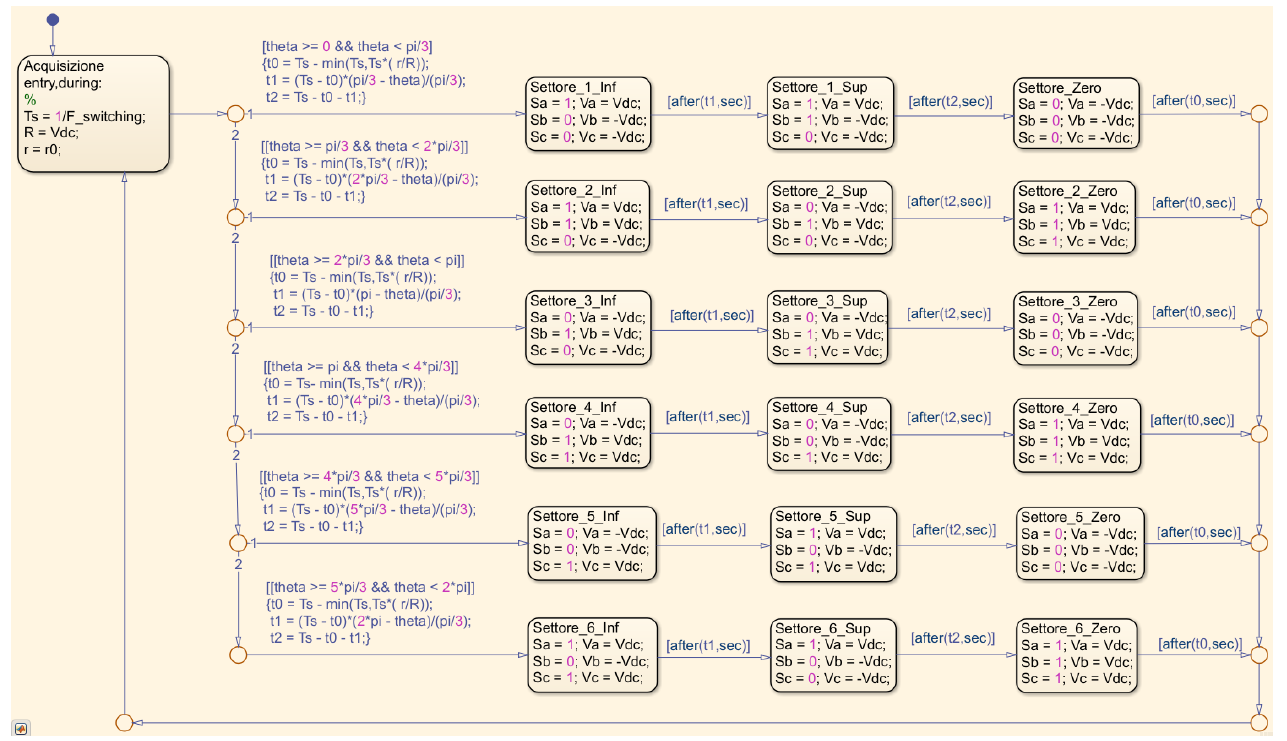
Figure 15. State machine representing the SVM modulation technique, integrated with STATEFLOW in Simulink